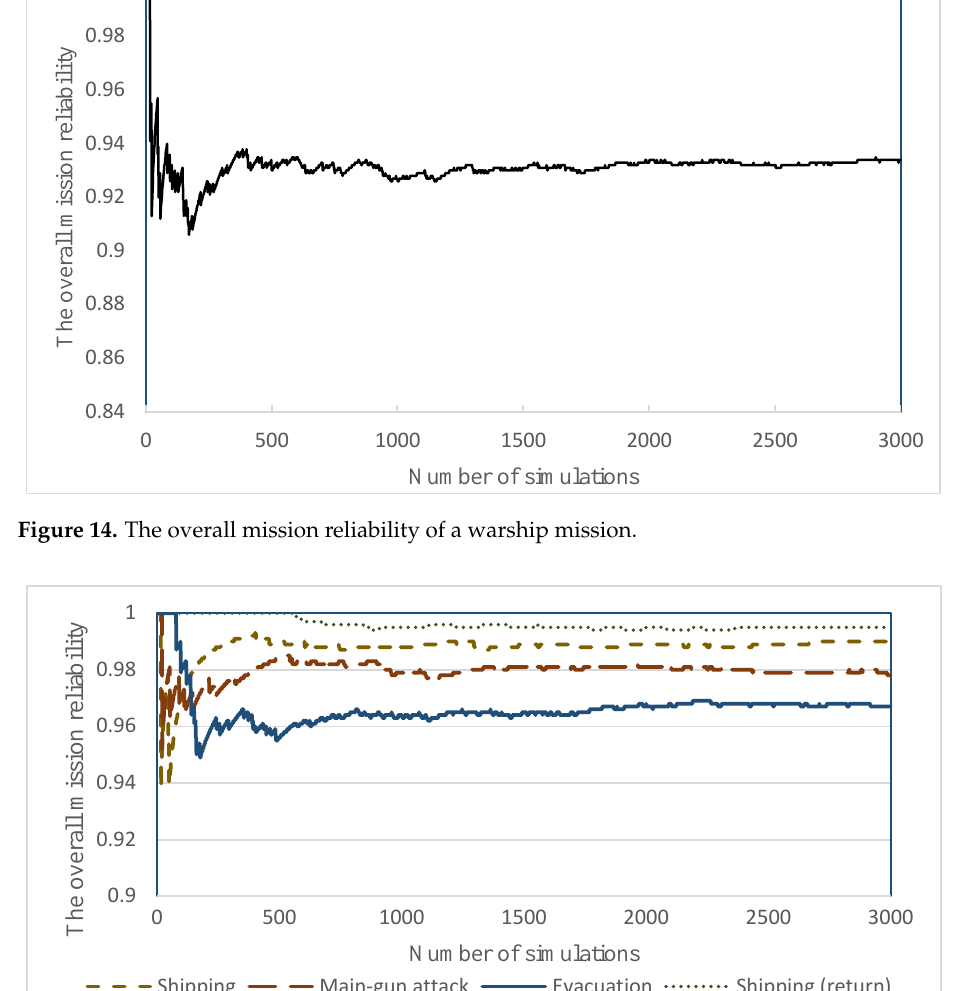
Table 6. The proportion of equipment fault time.